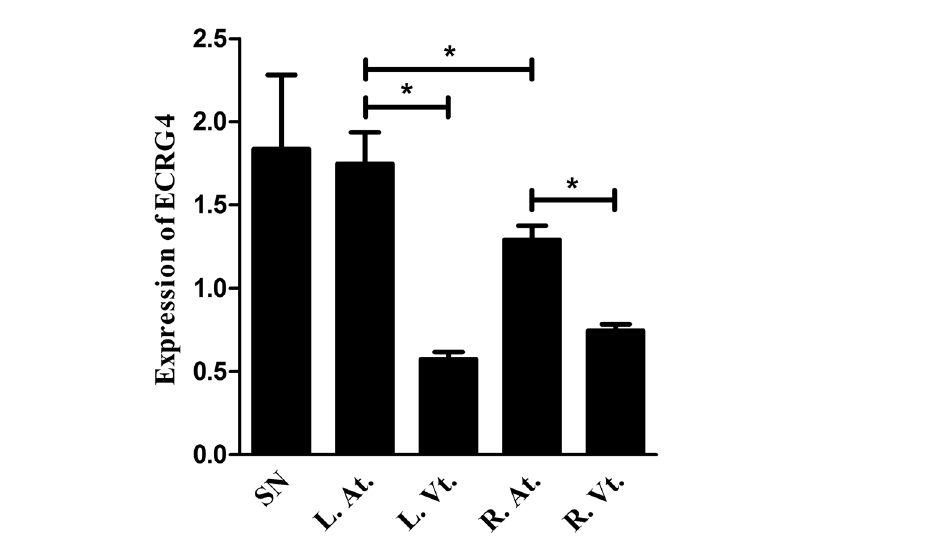
Figure 2. Distribution of Ecrg4 in adult rat heart by real-time PCR. Hearts were harvested from 9 adult rats, specimens of Sinus node, left and right atria (L. and R. At.), and left and right ventricles (L. and R. Vt.) were dissected, which were processed for total RNA isolation and real-time PCR as described in materials and methods. SN and L. At. express the highest level of ECRG4, followed by R. At. and both ventricles. Atria express significantly higher level of ECRG4 than ventricles (n = 9, P < 0.05), and L. At. express higher level of ECRG4 than R. At. (n = 9, P < 0.05). Data were presented as “Mean ± SD”, and the experiments were performed in triplicate and repeated three